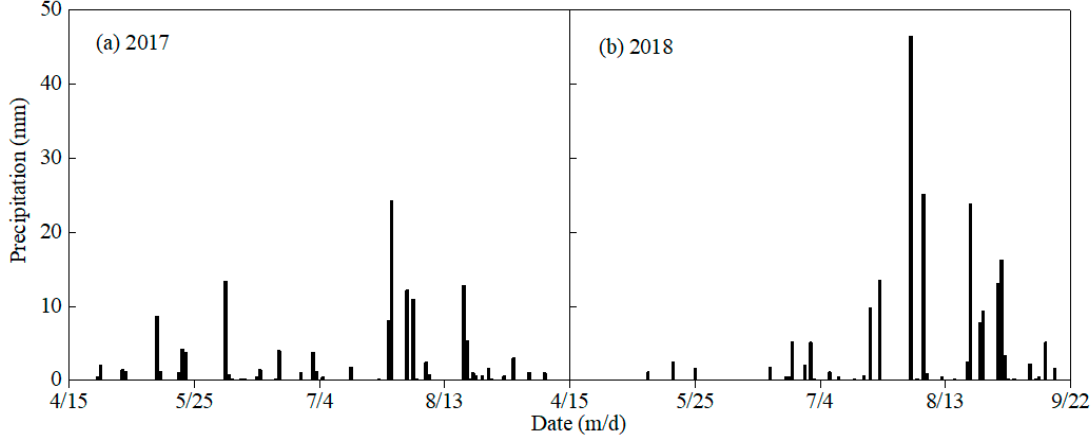
Figure 1. Precipitation during the growing period in 2017 ( a ) and 2018 ( b ).